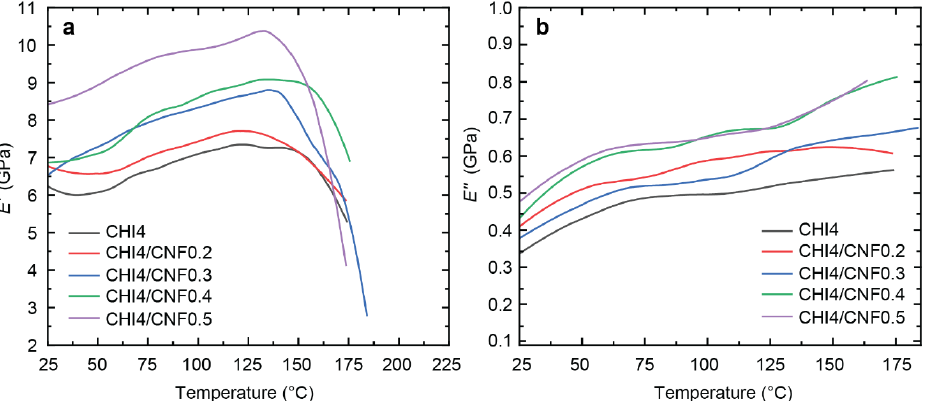
Figure 9. ( a ) Storage modulus ( E (cid:48) ) and ( b ) loss modulus ( E” ) as a function of temperature (T) of CHI/CNF fibers.